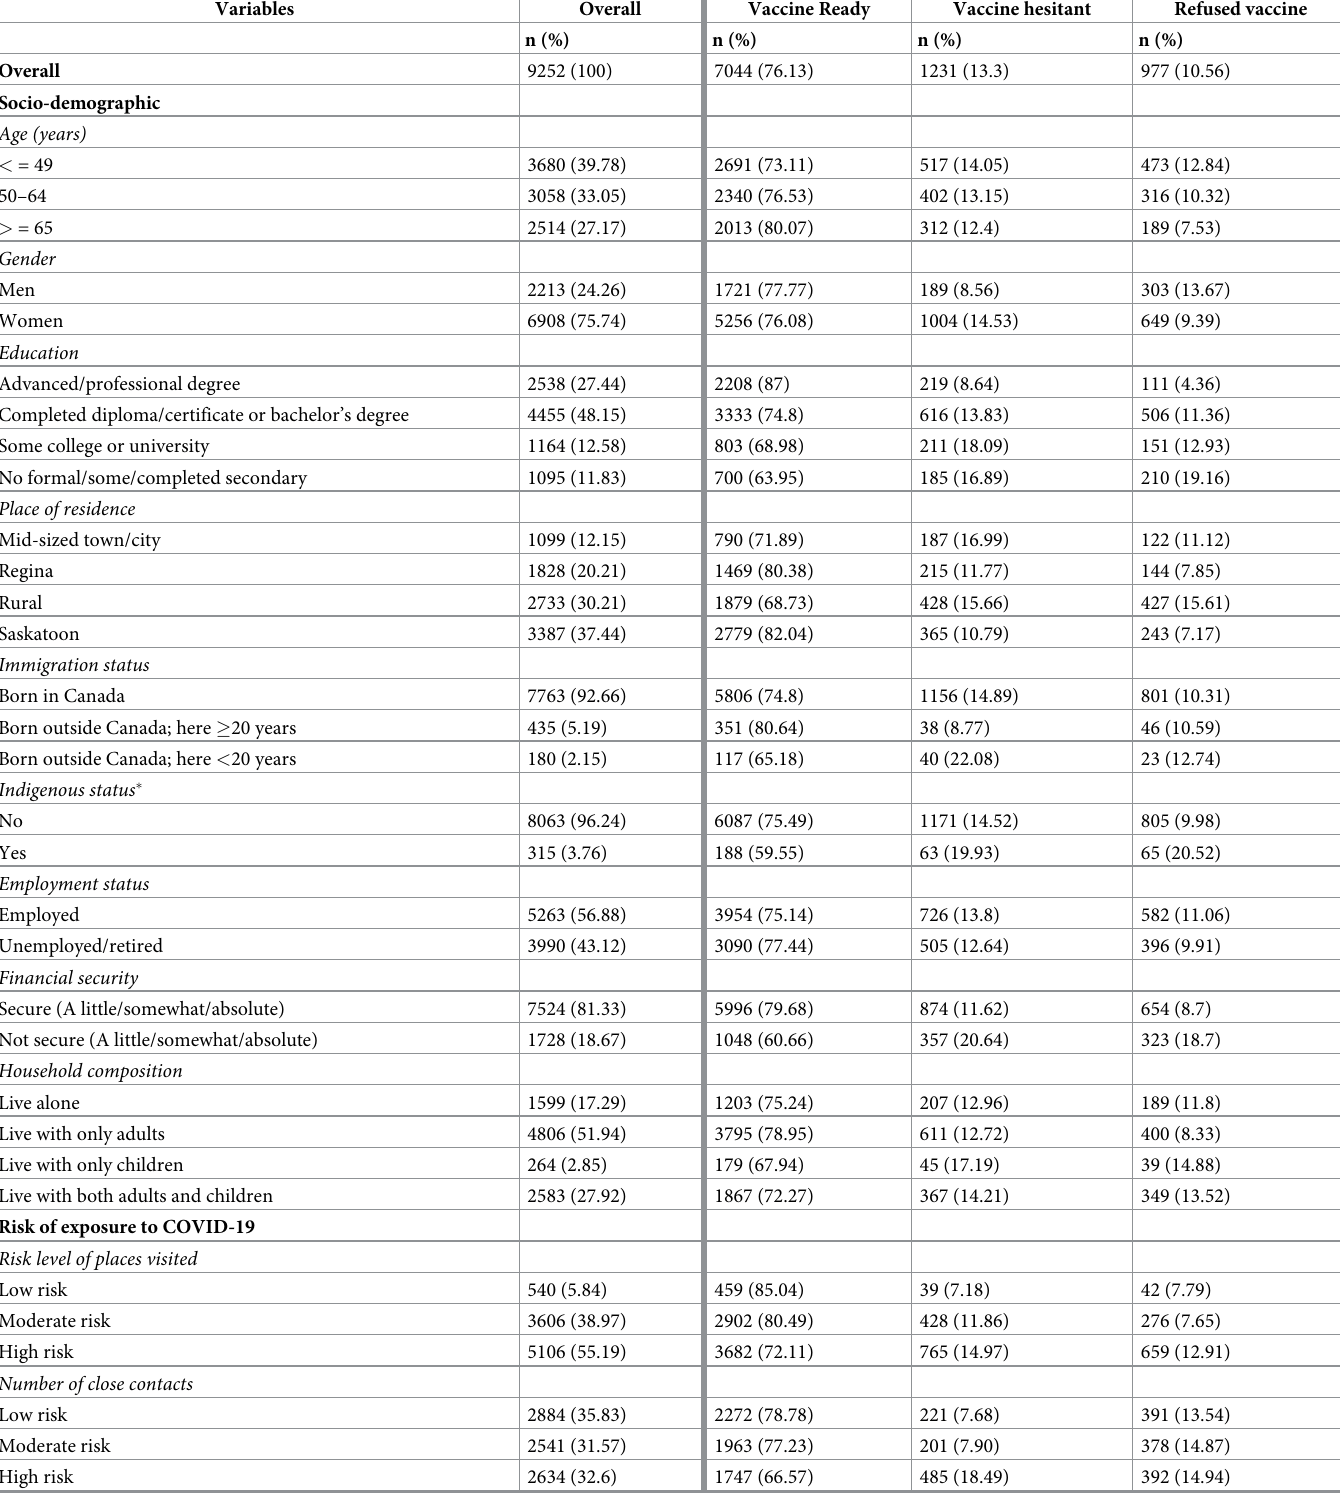
Table 2. Characteristics of respondents and vaccine intention rates in Saskatchewan,